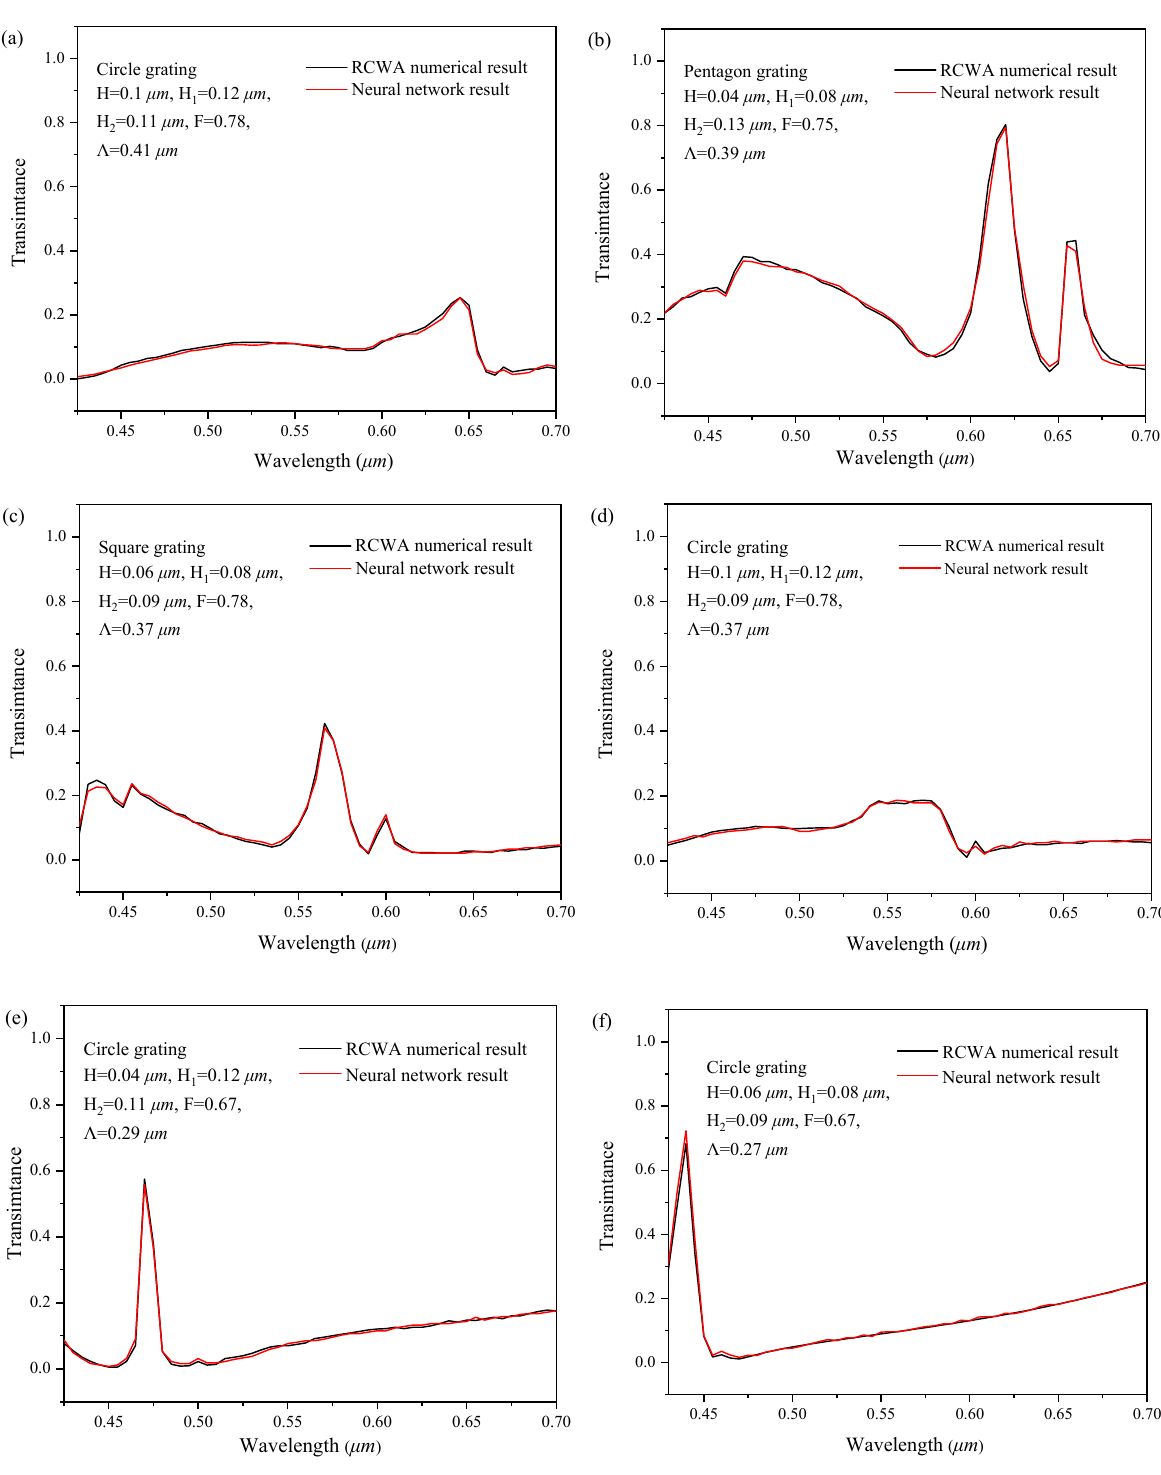
Figure 8. Comparison between the forward simulation and the RCWA numerical calculation for ( a ) circle gating with H = 0.06 µ m, H 1 = 0.12 µ m, H 2 = 0.11 µ m, F = 0.78, Λ = 0.41 µ m, ( b ) pentagon grating with H = 0.04 µ m, H 1 = 0.08 µ m, H 2 = 0.13 µ m, F = 0.75, Λ = 0.39 µ m, ( c ) square grating H = 0.06 µ m, H 1 = 0.08 µ m, H 2 = 0.09 µ m, F = 0.78, Λ = 0.37 µ m, ( d ) circle gating with H = 0.1 µ